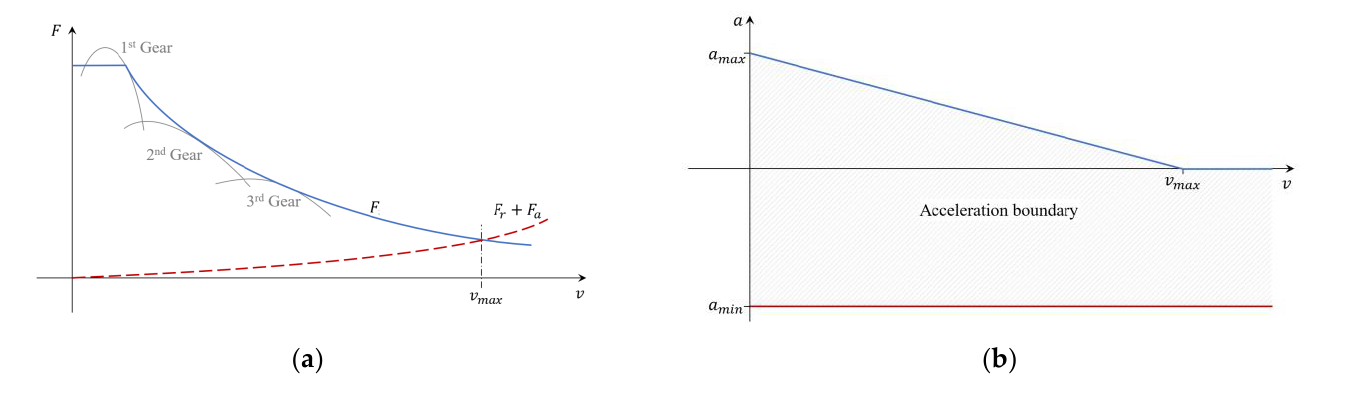
Figure 1. Constraints of longitudinal force and acceleration: ( a ) the constraint of longitudinal force varies with the transmission gear ratio; ( b ) the simplified acceleration constraint for the vehicle model.